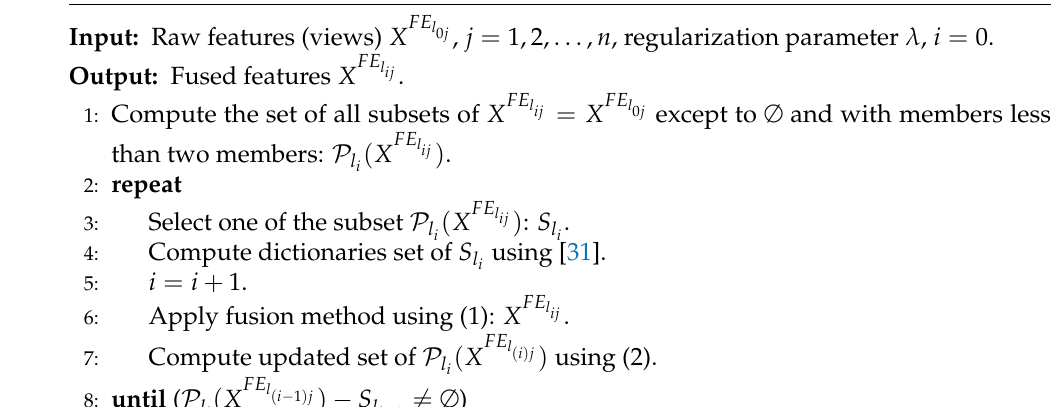
Algorithm 1 Feature extraction algorithm based on hierarchical fusion